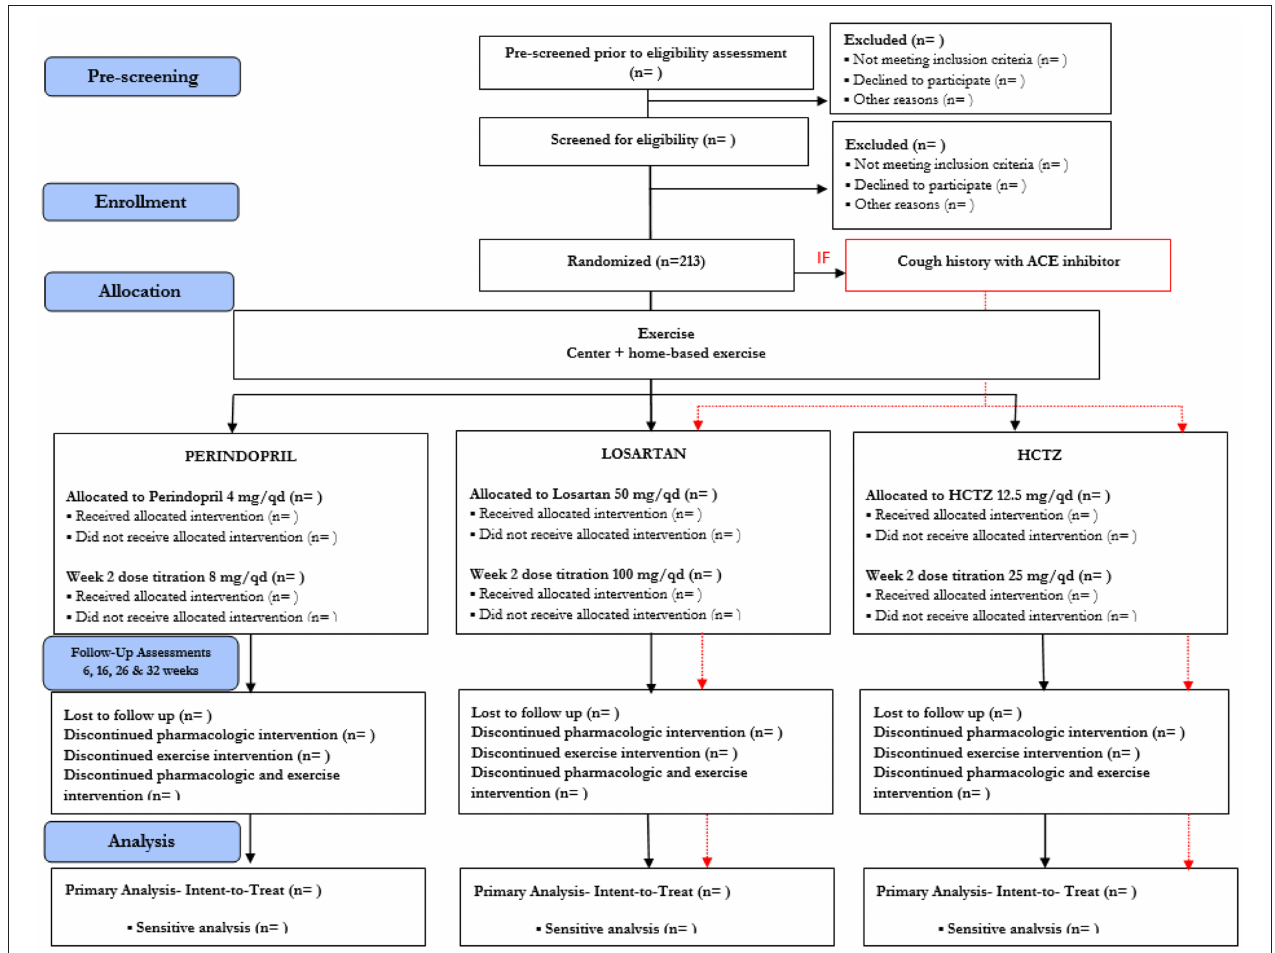
FIGURE 2 | Study Design in Consolidated Standards of Reporting Trials (CONSORT) Format. Due to safety, the study design will accommodate stratified randomization by cough history. Participants with cough history will only be randomized to either Losartan or HCTZ. For those without cough history, they will be randomized to Perindopril, Losartan, and